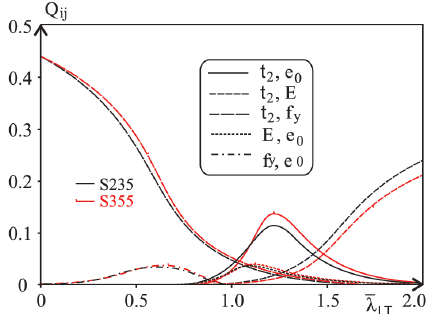
Figure 8. Second order quantile contrast indices 62×46 mm